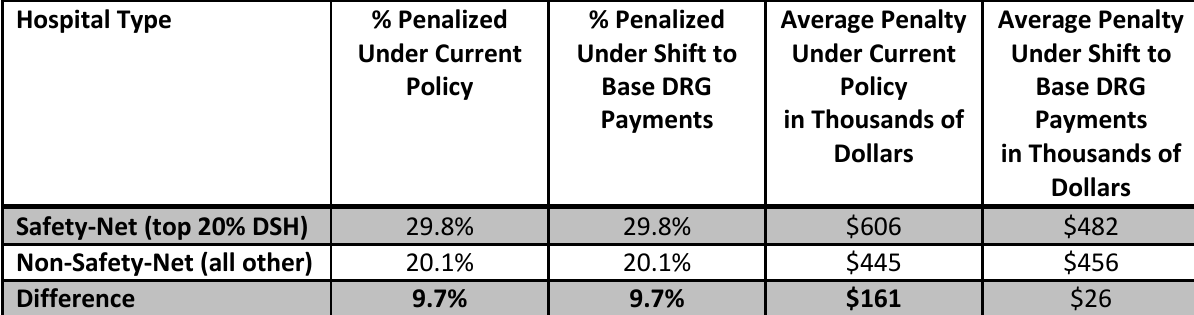
Table 6.20: Penalties Under Base DRG Instead of Total IPPS